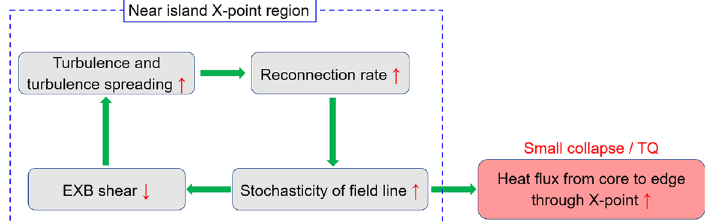
Figure 14. Diagrams of possible role of turbulence enhancement and related dynamics in facilitating the small collapse and the